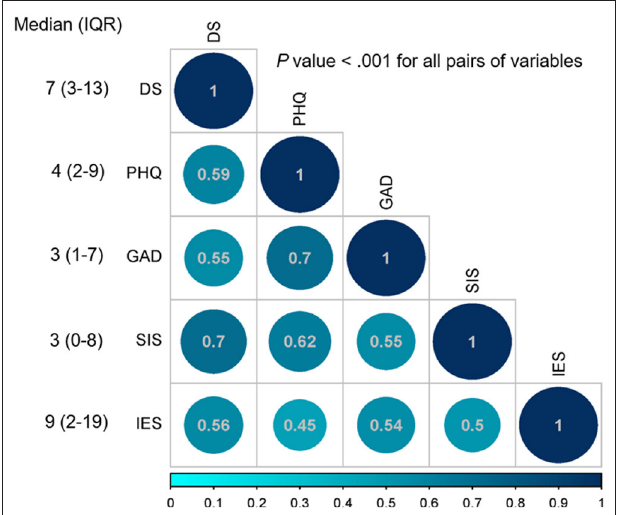
FIGURE 1 | Spearman’s rho correlation coefficients, median, and interquartile range (IQR). DS, Demoralization scale; PHQ-9, Patient Health Questionnaire-9; GAD-7: General Anxiety Disorder Scale-7; SIS, Subjective Incompetence Scale; IES, Impact of Events